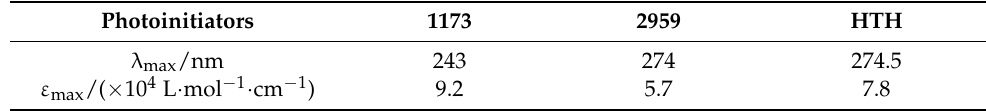
Table 1. The maximum absorption wavelength and maximum molar extinction coefficient of 1173, 2959, and HTH.